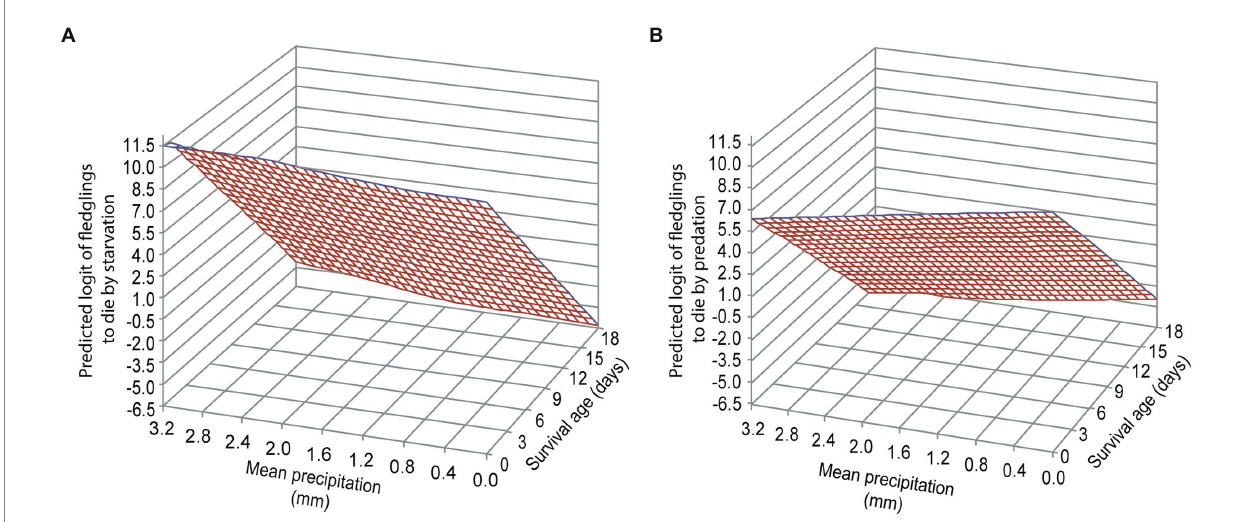
FIGURE 2 Fledglings’ probability of dying. Predicted logit values of fledglings’ probability of dying by starvation (A) and predation (B) of Tengmalm’s owl offspring during two post-fledging dependency periods (2019, 2021) plotted against the interaction of mean amount of precipitation and fledglings’ survival age.